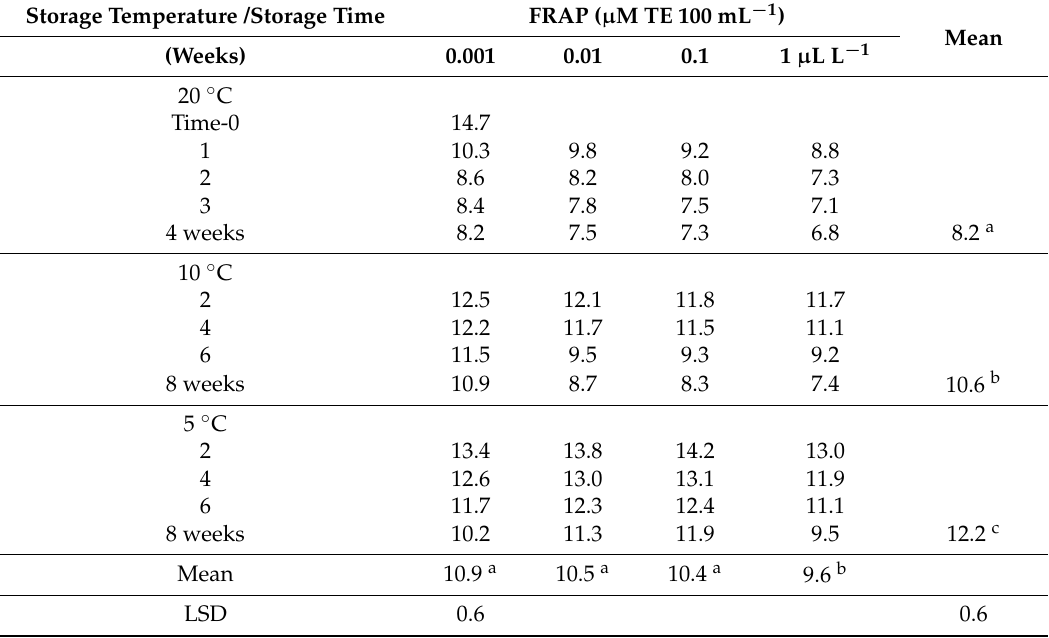
Table 7. FRAP activity of ‘Afourer’ mandarins during storage at 20, 10 and 5 ◦ C. Storage Temperature /Storage